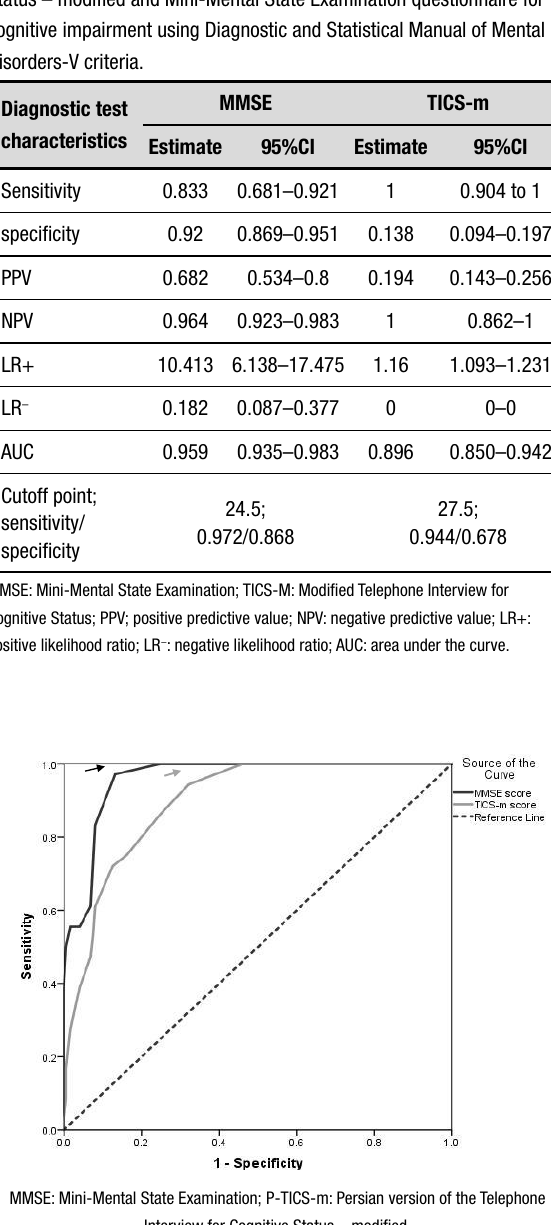
Table 3. Discriminant accuracy of Telephone Interview for Cognitive Status – modified and Mini-Mental State Examination questionnaire